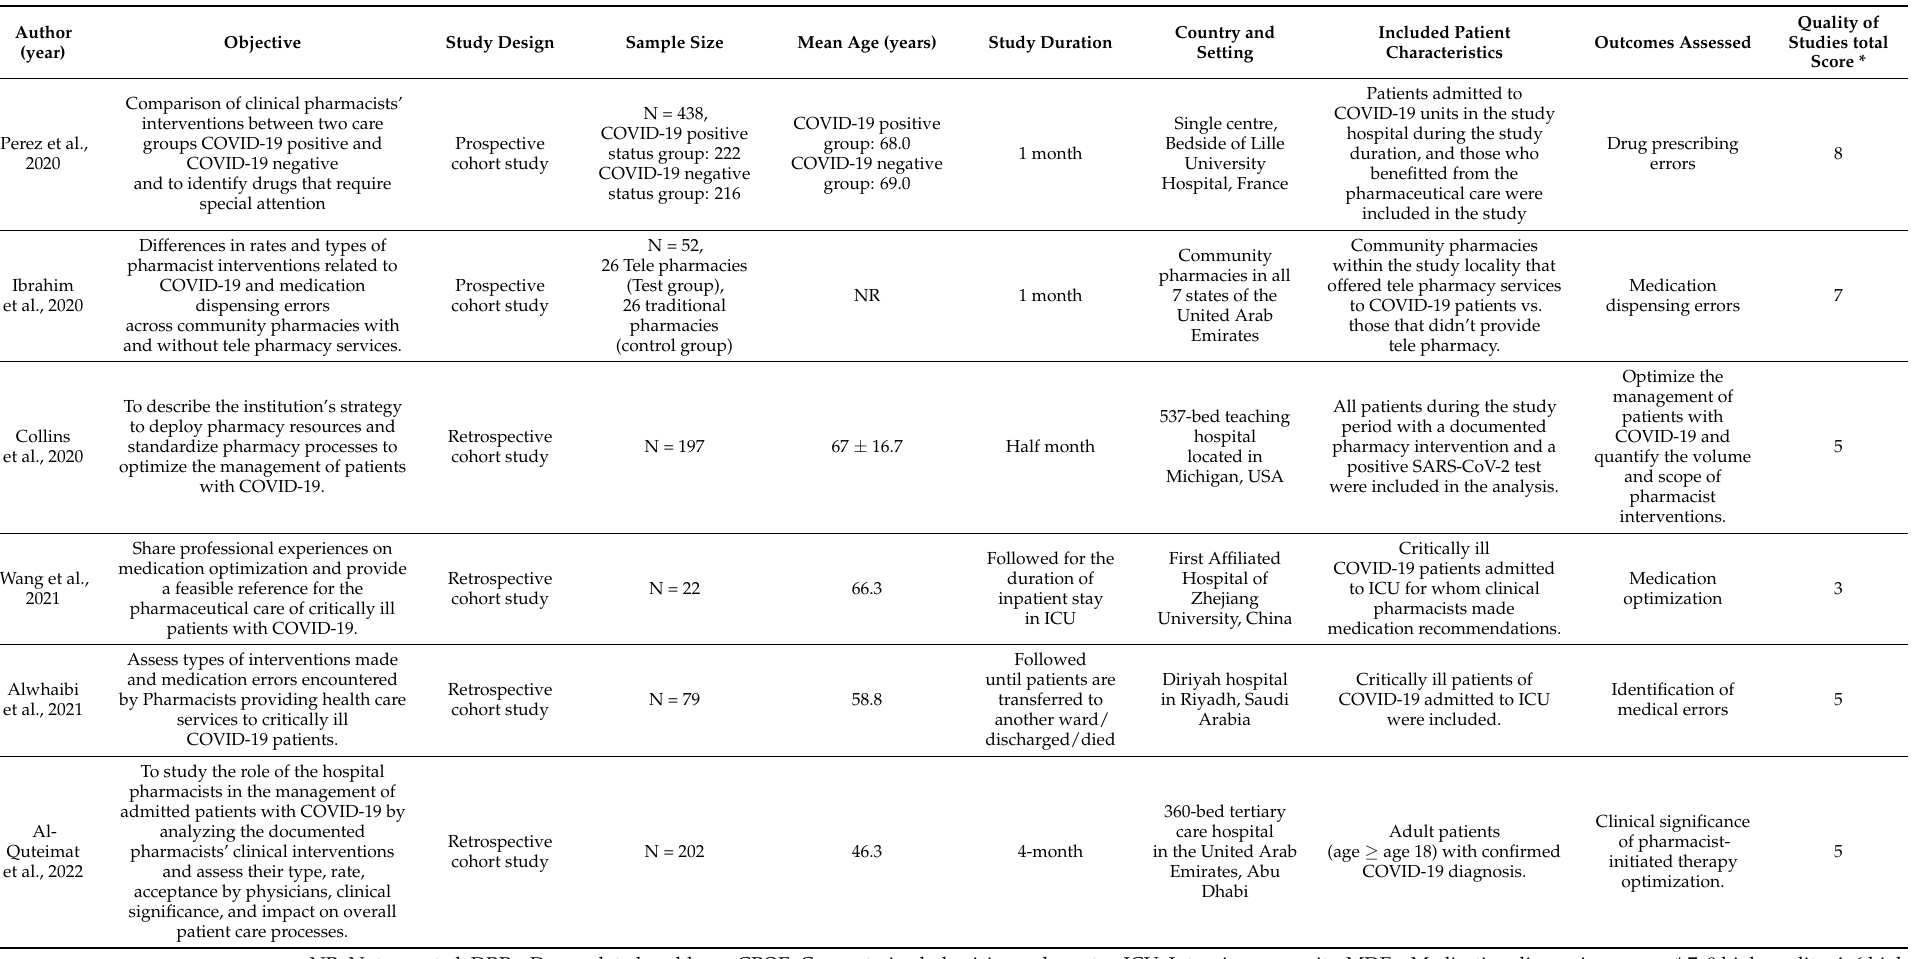
Table 1. Characteristics of included